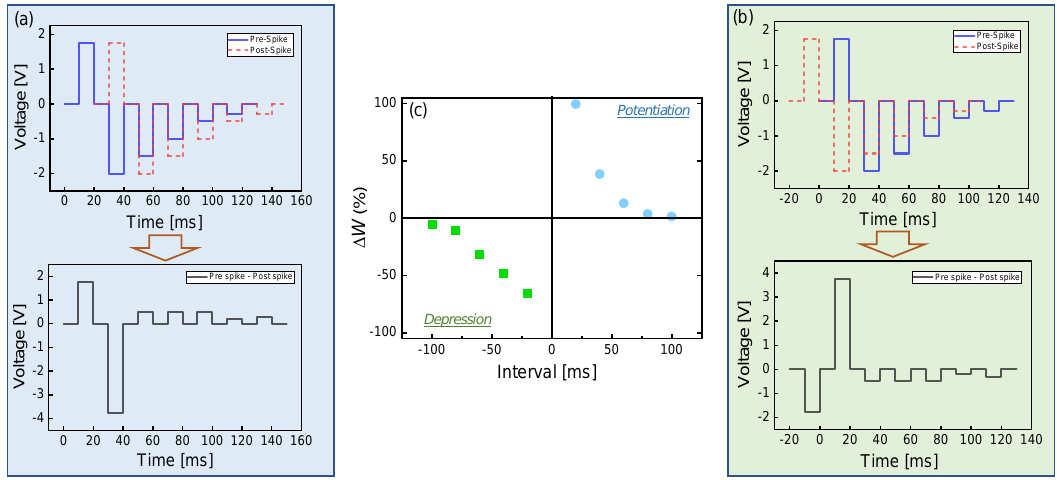
Figure 6. Spike-timing-dependent plasticity (STDP) of TiN / Ti / TiO 2 / SiO x / Si device: pulse schemes (pre- and postspike pulse trains) for ( a ) potentiaon and ( b ) depression; ( c ) STDP-like curve including potentiation and depression as a function of interval timing.